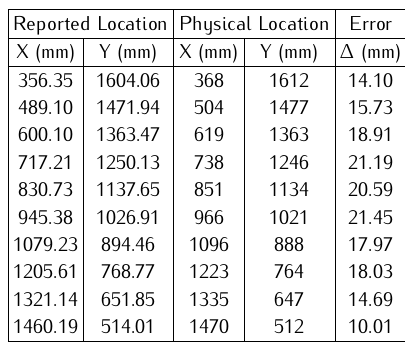
Table 1. Validation Measurements Table 2. Simple Path Measurements – Location